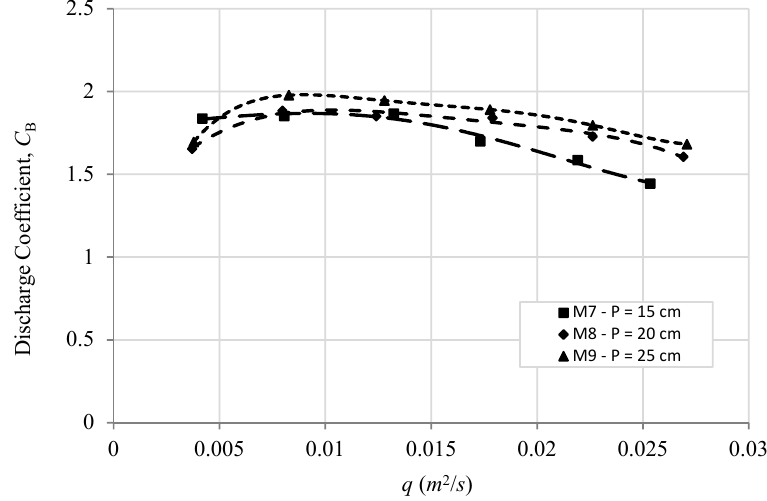
Figure 16. Discharge coefficient, C B , vs. unit discharge, q, for models M7, M8, and M9.